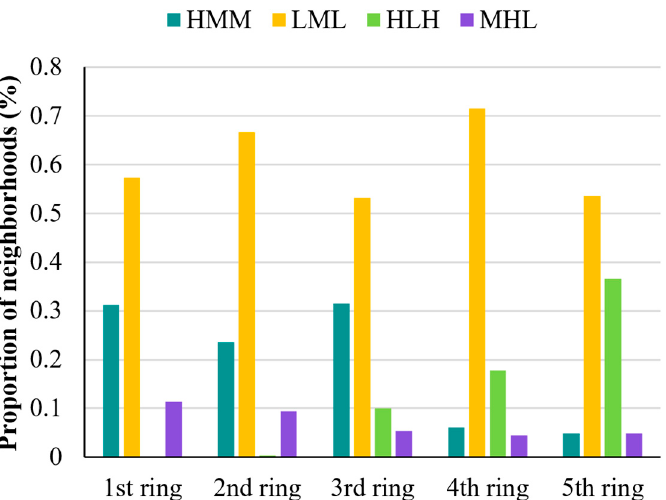
Figure 8. Statistical analysis across urban rings of the proportion of four accessibility types of neigh- borhoods.